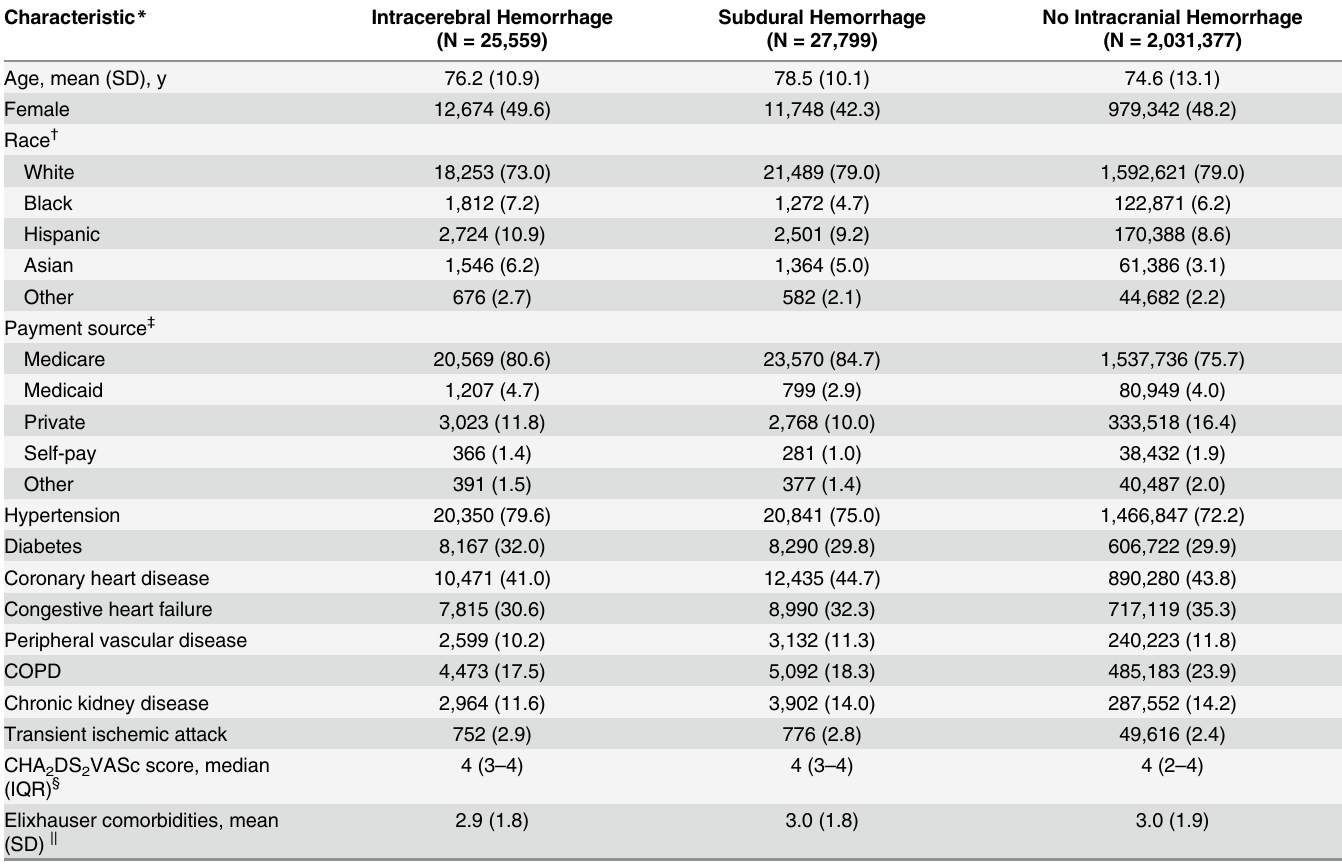
Table 1. Characteristics of Patients with Atrial Fibrillation, Stratified by the Occurrence and Type of Intracranial Hemorrhage. Characteristic